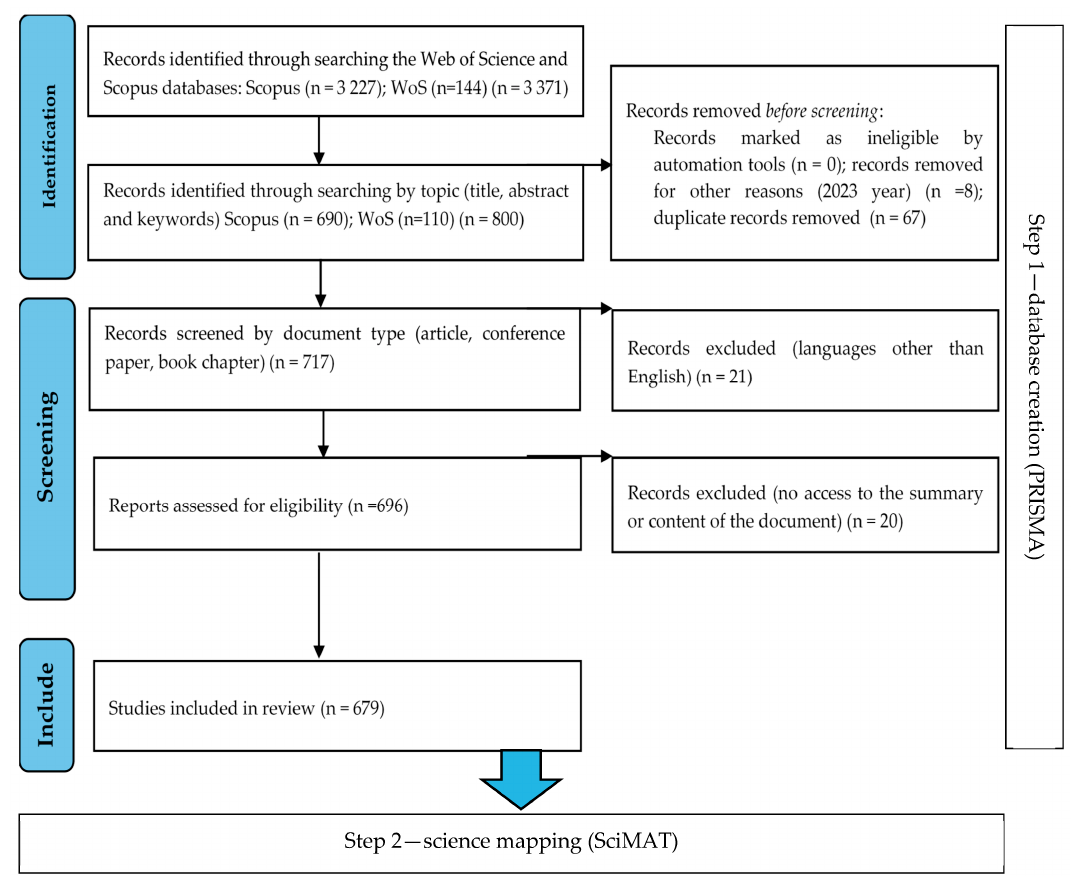
Figure 2. Mapping energy sector from risk management research perspective—the PRISMA flow diagram.